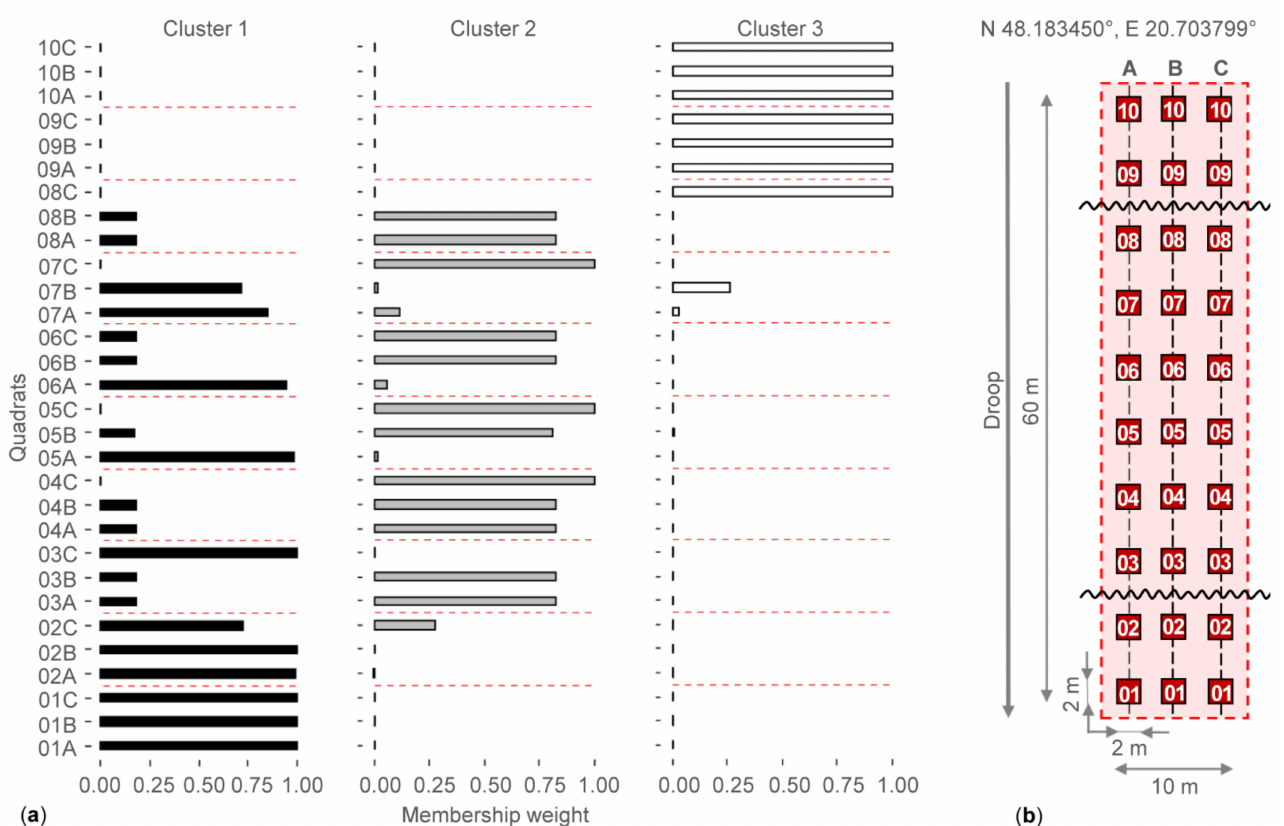
Figure 1. Membership weight of the quadrats in the three optional clusters, based on moisture requirement (fuzzy c-means clustering) ( a ), and the real slope position of the quadrats ( b ). In each quadrat, the moisture requirement (WB) is expressed as the cover-weighted mean WB of the vegetation-forming species, where the WB is defined according to the system of Borhidi [31]. Notation: A, B, C—codes of the transects designated along the slope; 01–10—codes of the quadrats designated in the